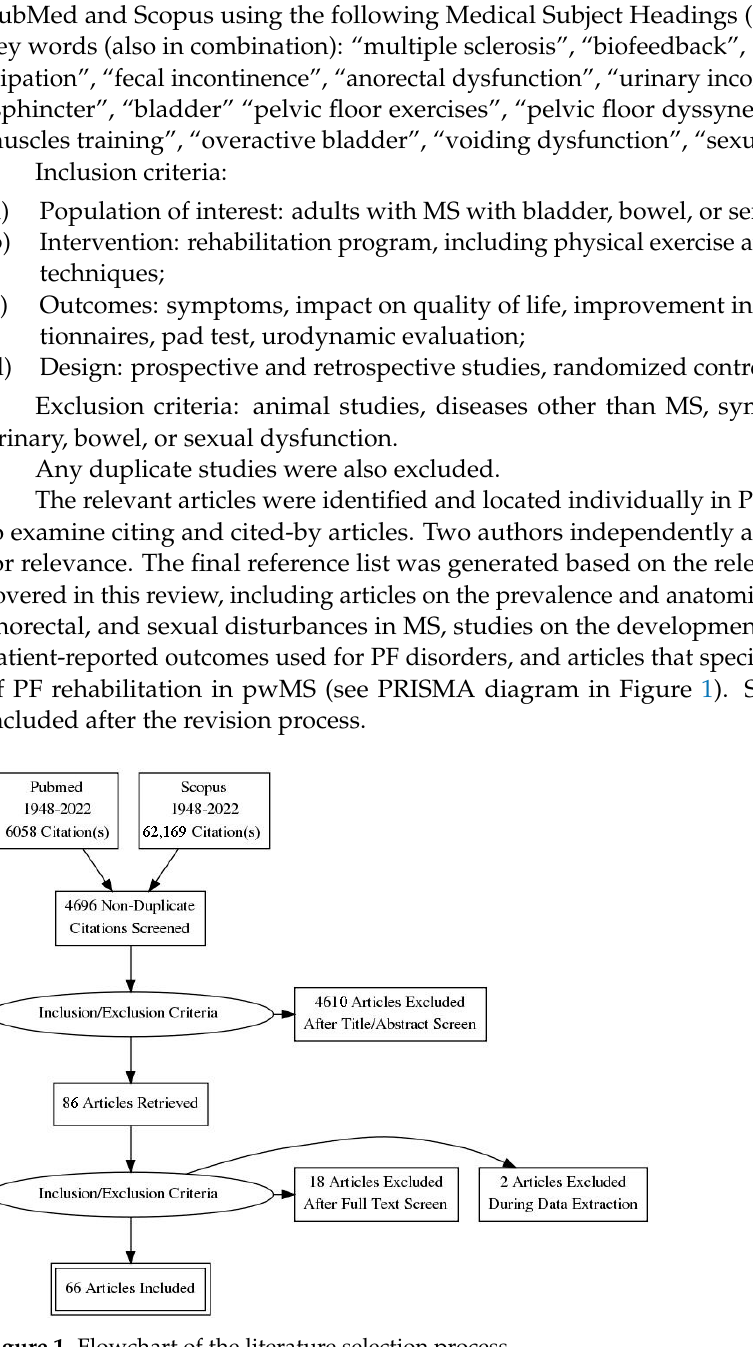
Figure 1. Flowchart of the literature selection